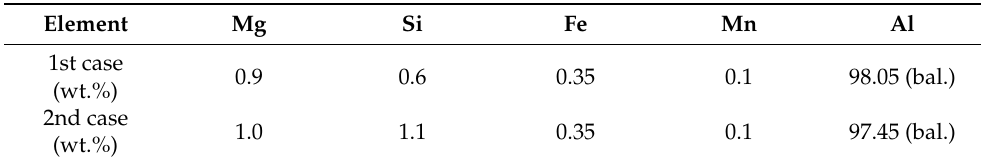
Figure 1. Simulation procedure analysis.